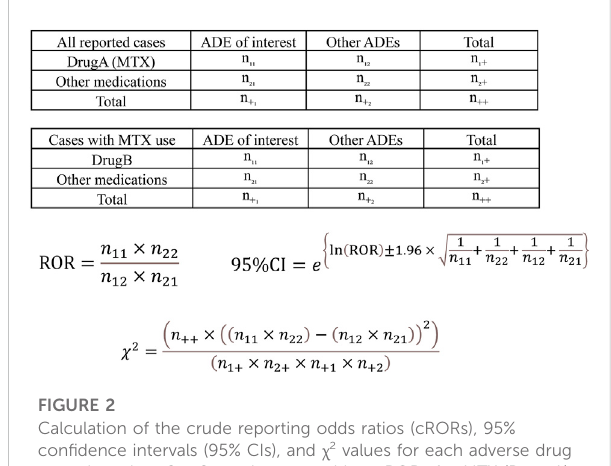
FIGURE 2 Calculation of the crude reporting odds ratios (cRORs), 95% con fi dence intervals (95% CIs), and χ 2 values for each adverse drug event based on 2 × 2 contingency tables. cRORs for MTX (Drug A)- related adverse events were calculated with the upper 2 × 2 contingency table among all reported cases. The cRORs with concomitant drugs (Drug B) were calculated with the lower 2 × 2contingencytableamongcaseswithMTX(DrugA)use.ADE,adverse drug event; MTX,